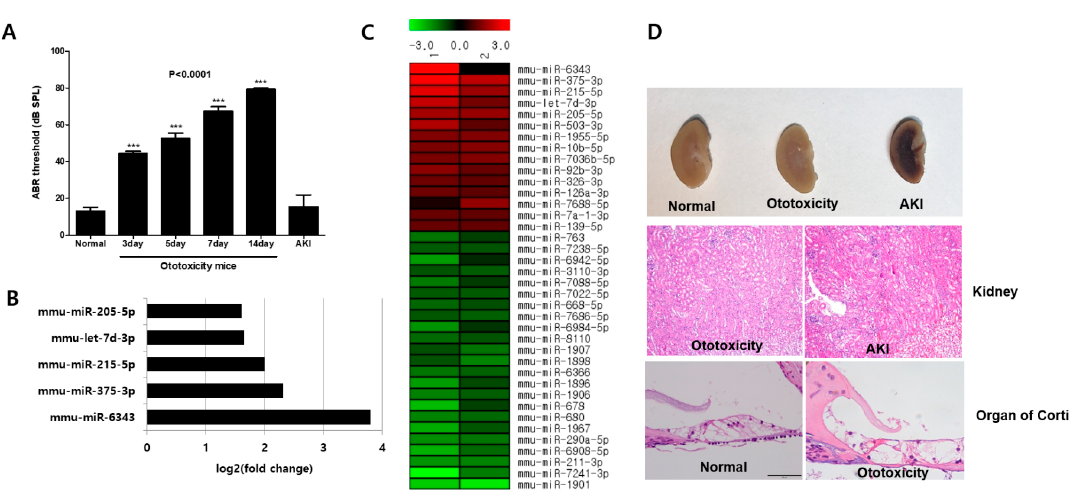
Figure 1. Auditory brainstem response (ABR) threshold test and global miRNA expression profiles in ototoxicity-induced mice. ( A ) The ABR threshold shifted on days 3, 5, 7, and 14 in the ototoxicity mice group gradually increased than control group. The hearing loss was not observed in the control acute kidney injury (AKI) mouse model. *** p < 0.0001. ( B ) Microarray analysis of circulating miRNAs revealed 5 major miRNAs that increased in the serum of the ototoxicity-induced mouse model compared to the control. ( C ) Cluster heat maps illustrated clustering of circulating miRNA in the ototoxicity-induced mice. Hierarchical clustering analysis between groups of ototoxicity-induced and normal mice represent higher and lower relative expression (red and green, respectively), which were based on differential expression of 38 significantly altered miRNAs. ( D ) Hematoxylin and eosin stained tissue sections from the organ of Corti and Kidney. The AKI model showed an infarction in the outer medullar but was normal in the ototoxicity mouse model. Damage to the inner and outer hair cells and disappearance of supporting cells was observed in the organ of Corti of ototoxicity-induced mice.